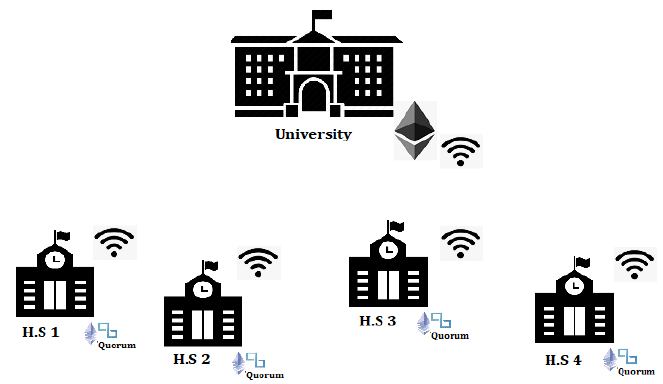
Figure 3. Specific system for e-vote application.